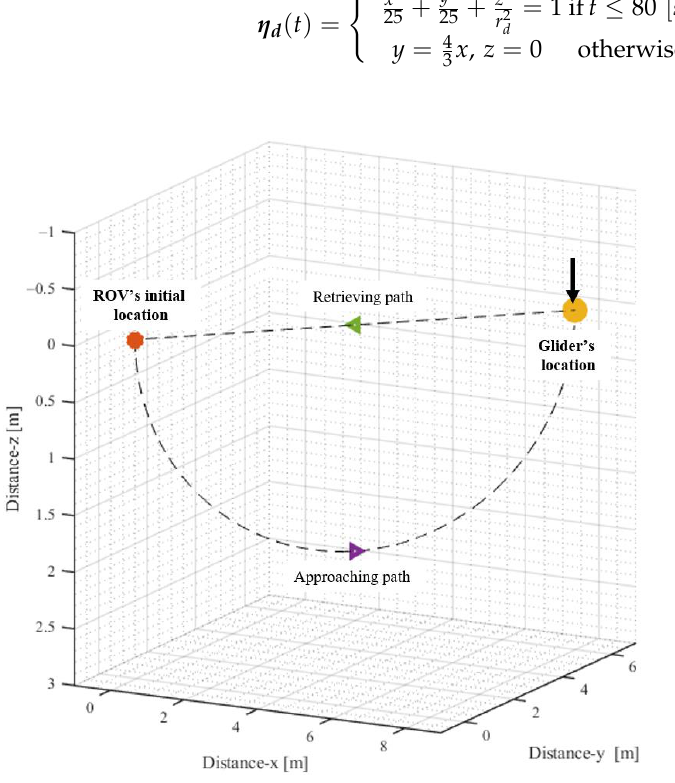
Figure 7. The simulation scenario.